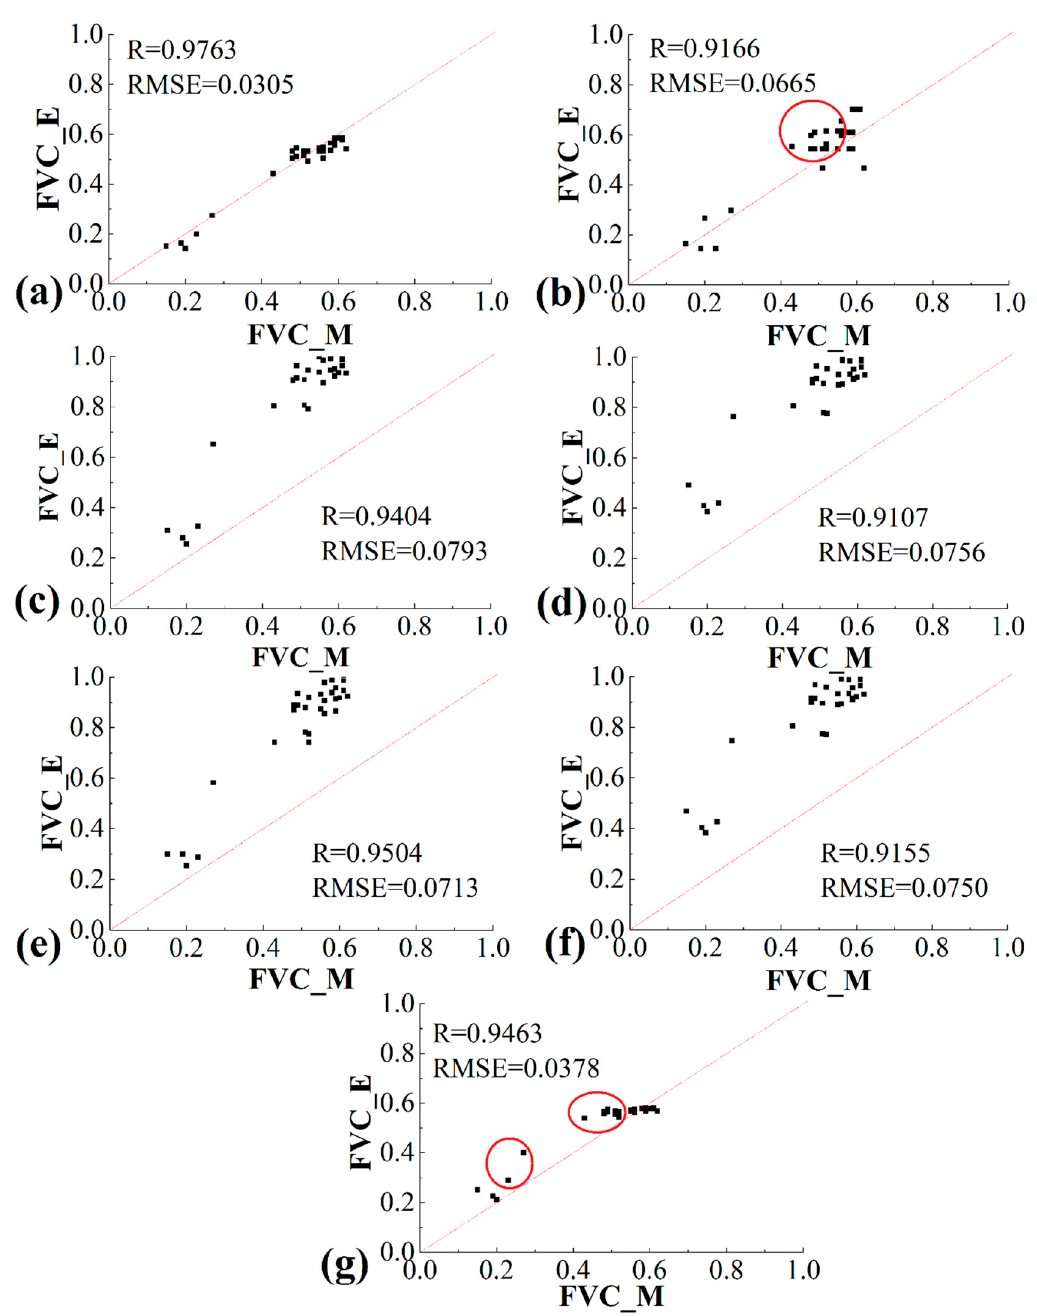
Figure 6. The Statistics of the FVC of row crops simulated by the different algorithms in the World-View 3 and field measurement data. ( a ) MFS + BPNN, ( b ) PROSAIL + BPNN ( c ) U-SMA-2, ( d ) C-SMA-2, ( e ) U-SMA-5, ( f ) C-SMA-5, and ( g ) empirical method. Here FVC_E is estimated FVC, FVC_M is measured FVC, and the red circle represents an overestimated area.